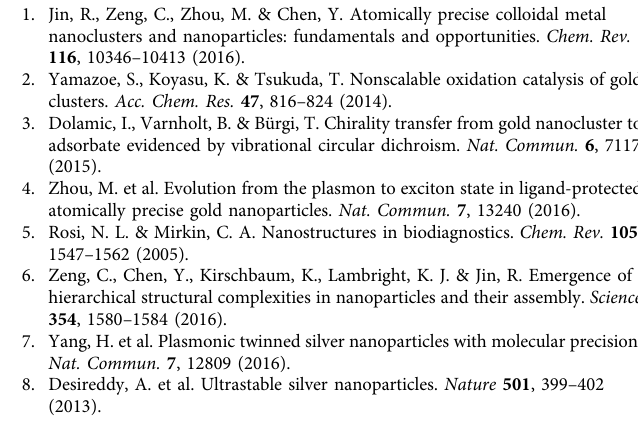
(Fig. 5c, Path 2, shown by red arrows, Supplementary Movie